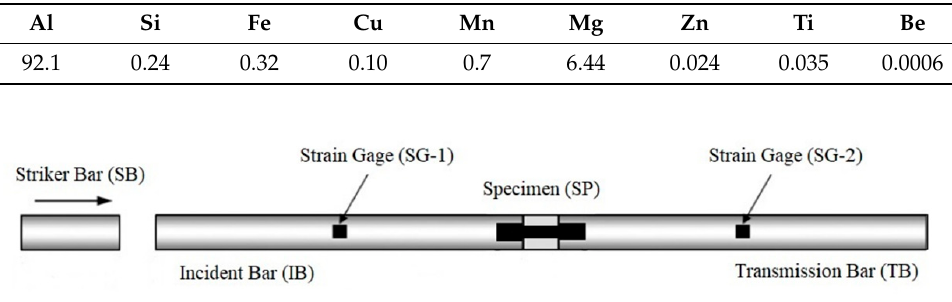
Figure 2. The specimen geometry used for dynamic preloading and cycle tests (sizes in mm).